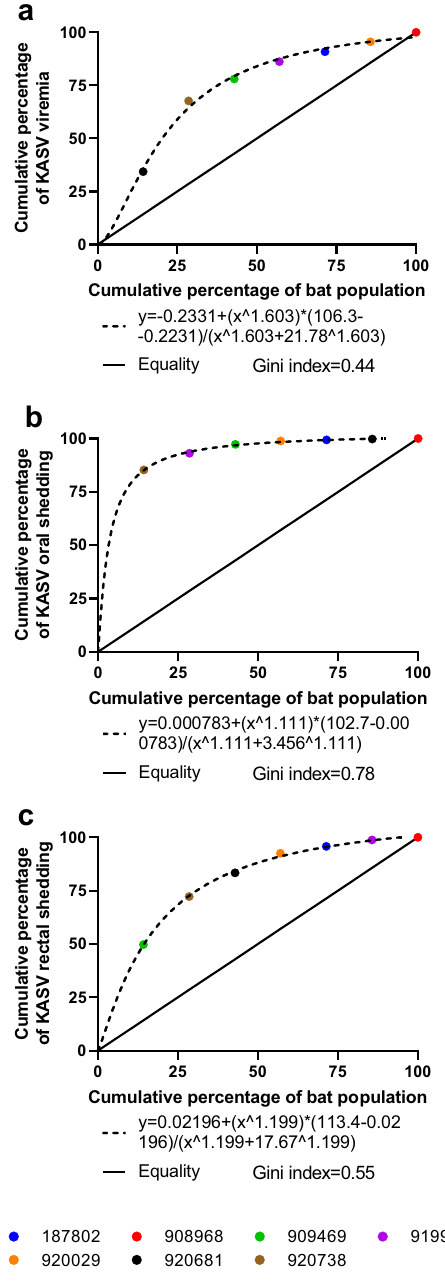
Figure 4. Cumulative Kasokero virus (KASV) shedding detected in specimens collected from serially-sampled, KASV-inoculated bats. Lorenz curves of cumulative percentage of the bat population versus cumulative percentage of KASV shedding detected in the ( a ) blood, ( b ) oral mucosa, and ( c ) rectum ranked in descending order (i.e., first symbol on the curve represents the bat which had the highest cumulative percentage of